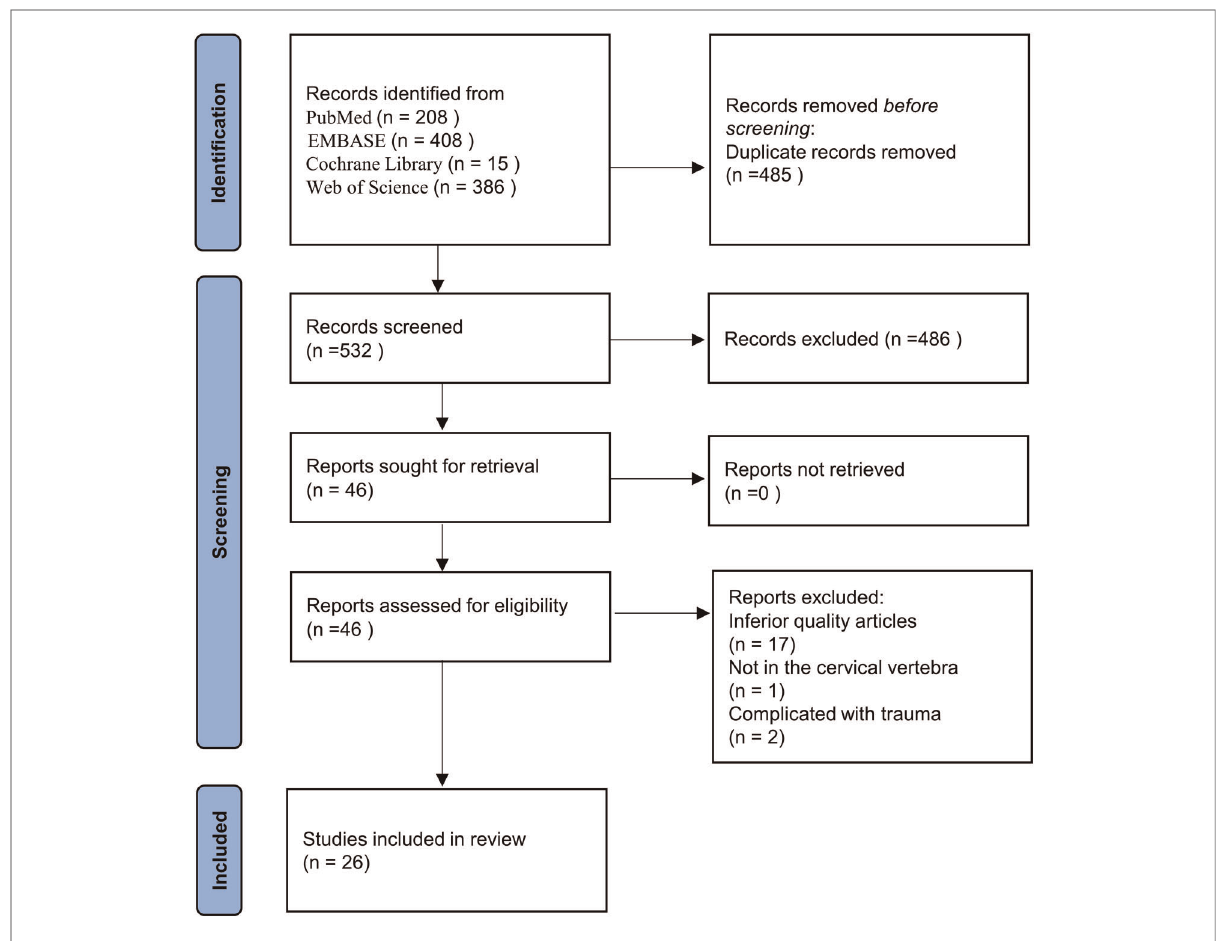
FIGURE 1 Flow chart showing the process of article